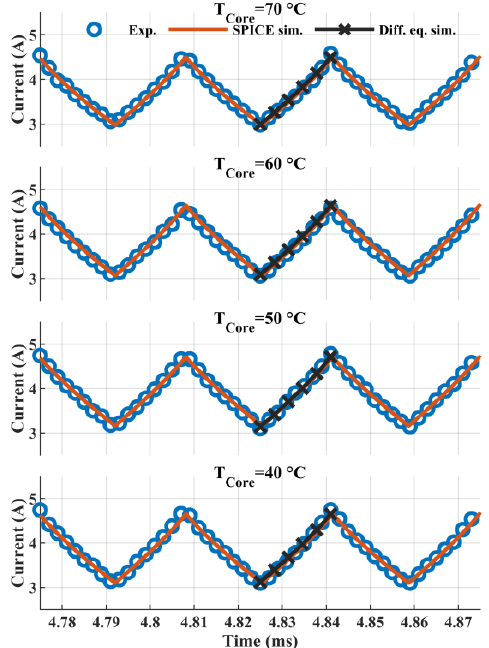
Figure 8. Comparison of the experimental current waveform with the simulation results from SPICE and the differential equation for a duty cycle of 48% at different temperatures.